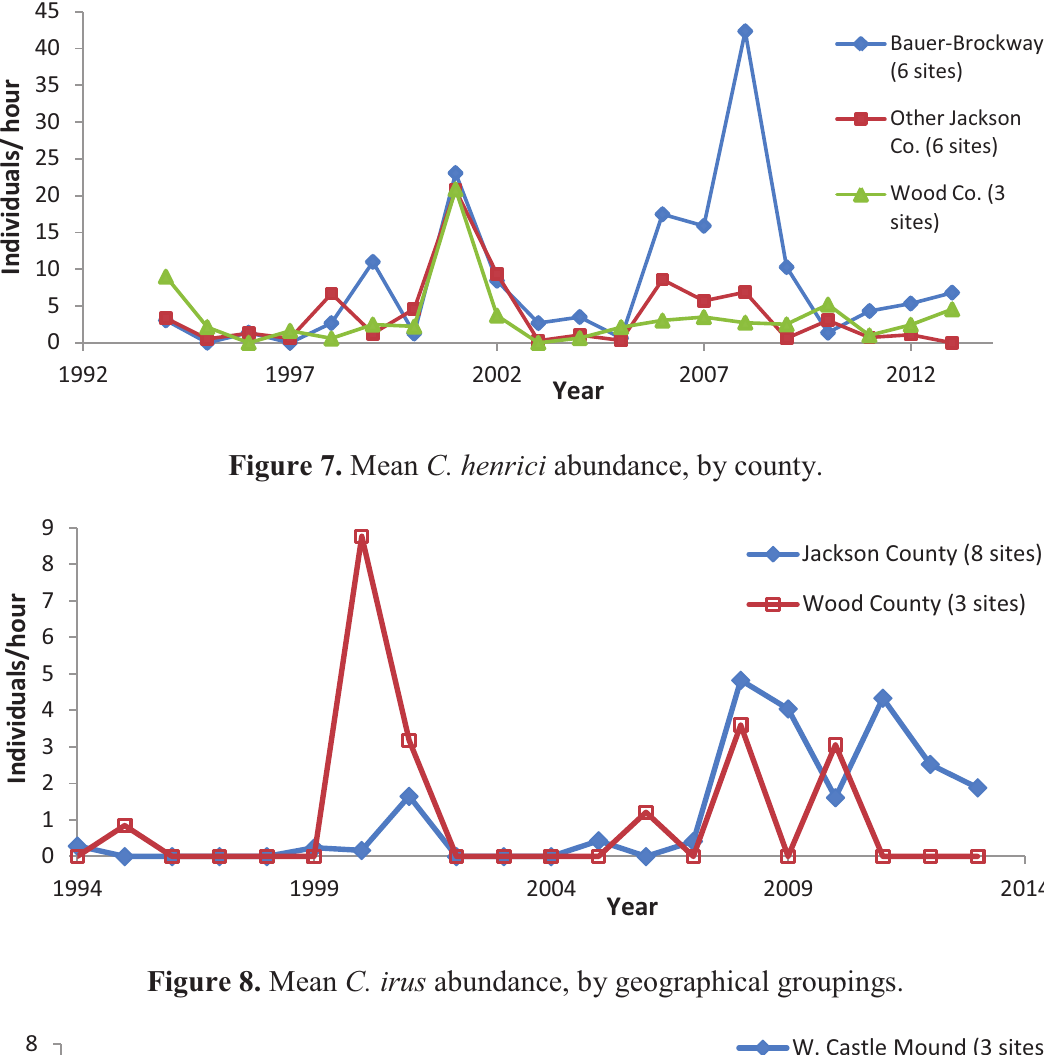
Figure 6. Mean C. niphon abundance by three site groupings.